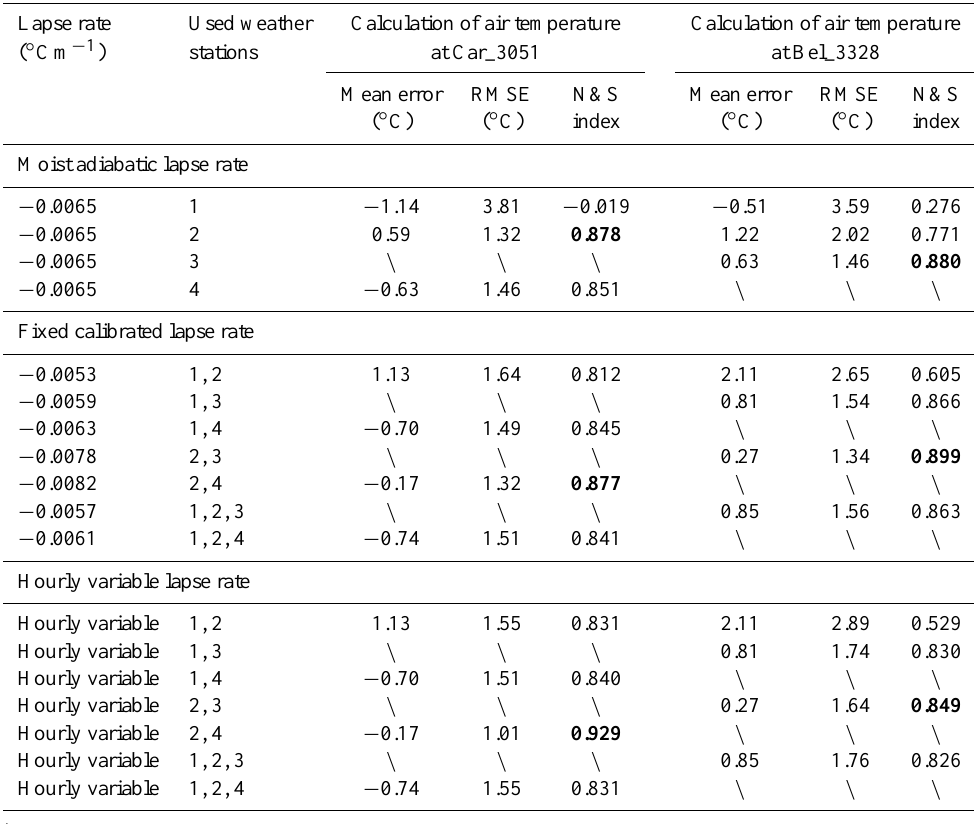
Table 3. Validation statistics for ambient temperature calculations (global data set including summer 2010 and 2011) ∗ . Lapse rate Used weather Calculation of air temperature